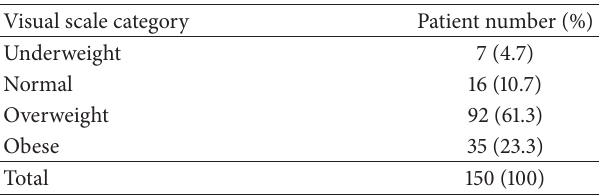
Table 5: Patients’ perceptions on whether they need to lose weight according to where they think is normal for them on the visual